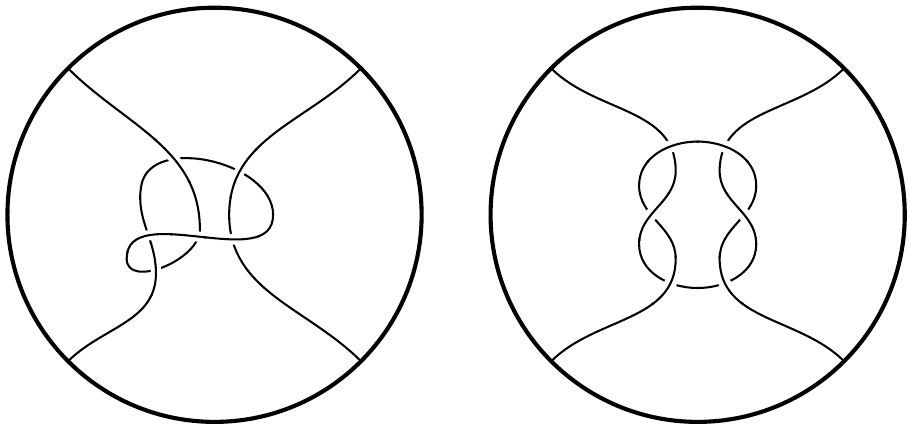
Figure 5. Examples of 2-tangles which are not rational, so may not be untangled only by moving the boundary points. No such worldline topologies appear as saddle points to the gravitational path